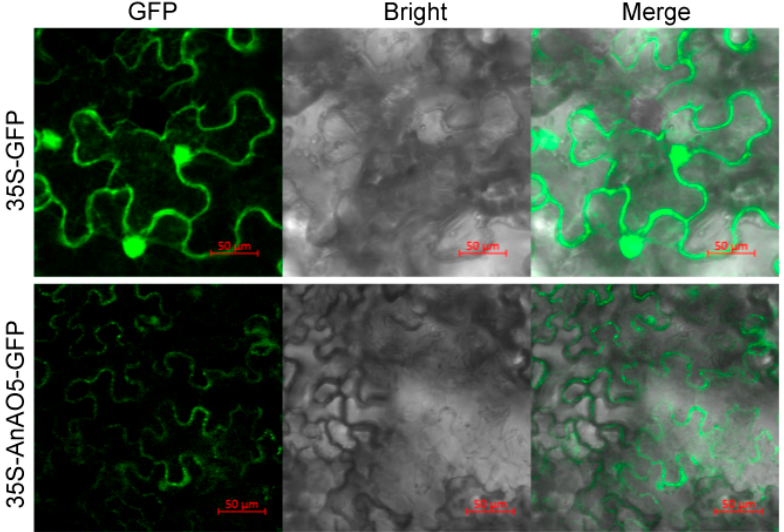
Figure 10. Subcellular localization analysis of AnAO5 protein by transiently expressing the AnAO5 gene in tobacco. Bars = 50 μ m.